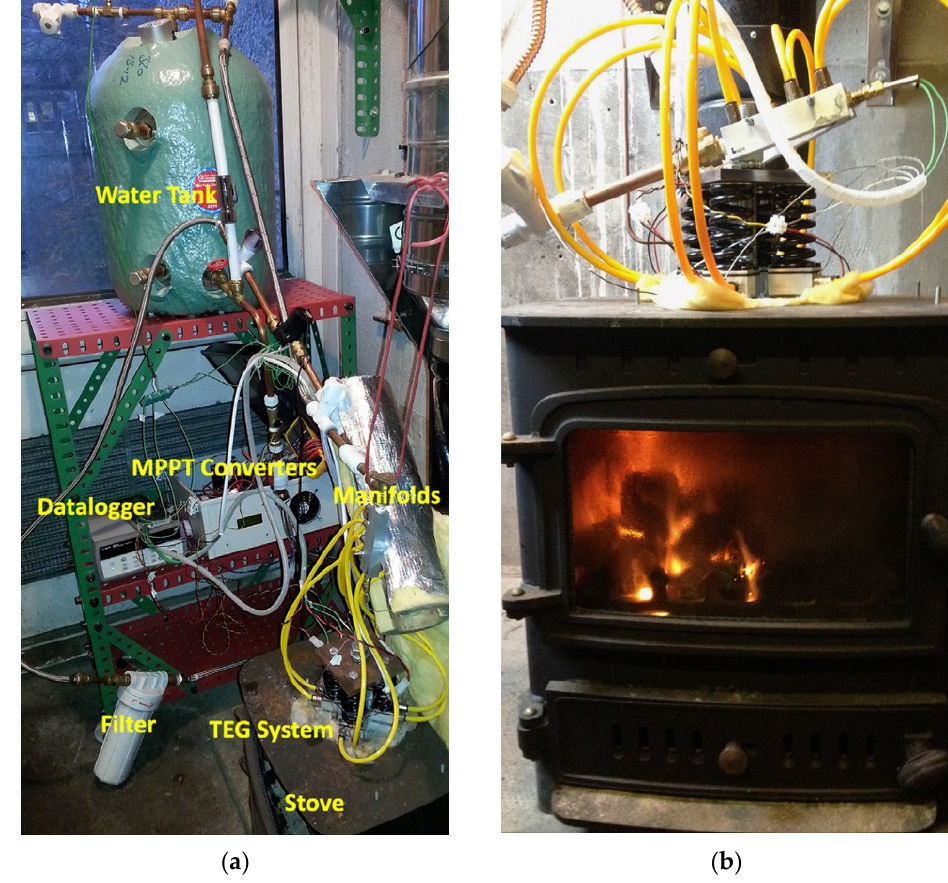
Figure 10. Experimental stove TEG system: ( a ) Complete CHP system; ( b ) Close-up image of the stove. Reprint with permission [68]; Copyright 2021, Elsevier.